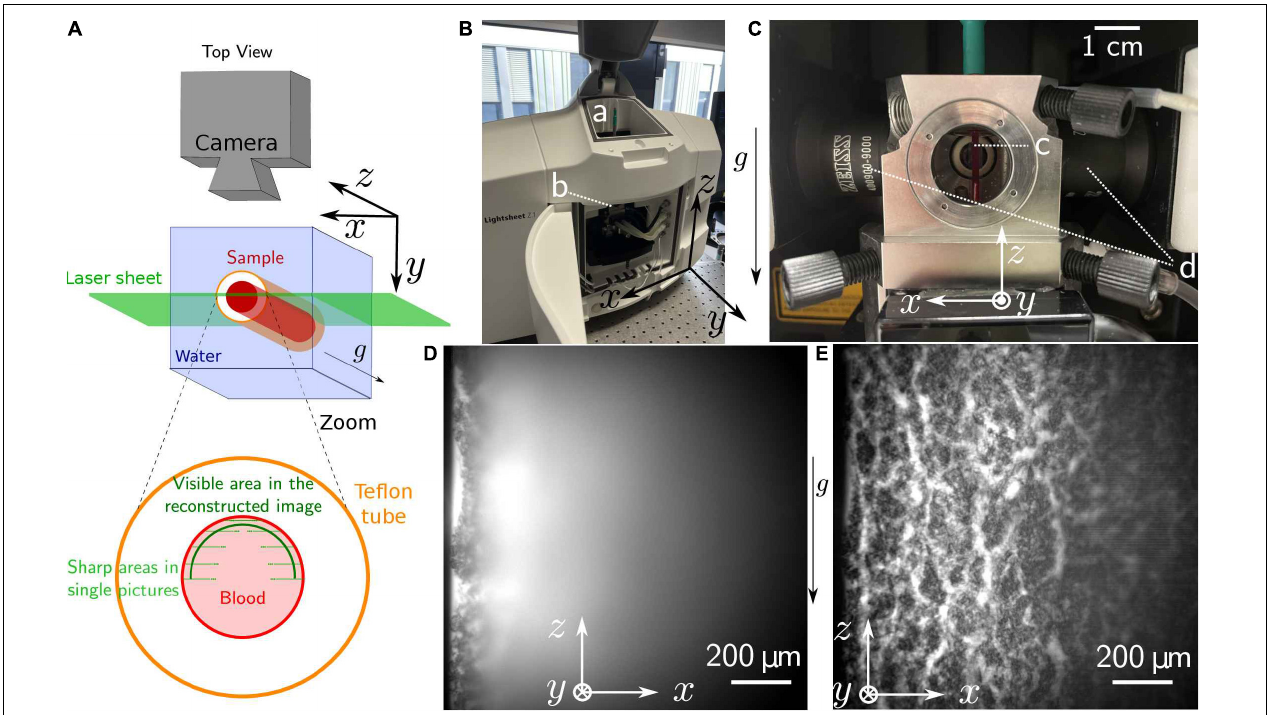
FIGURE 3 | Light-sheet microscopy. (A) Scheme of the setup. The position of the taken pictures and the location of the reconstructed are also represented. (B) Picture of the device. One can see the opening (a) through which the samples are introduced in (b) the microscopy chamber, filled with water through the neighboring pipes. (C) Zoom on the microscopy chamber, containing (c) the sample, and surrounded by (d) the lenses focusing the laser into vertical sheets. The objective is seen behind the sample. (D) Raw picture as obtained during the experiment. (E) Reconstructed picture obtained after postprocessing of a z -stack. This stack was obtained after 90 min sedimentation time of the sample. The brightness of each pixel is created by the fluorescence of the plasma, erythrocytes are then present in the black